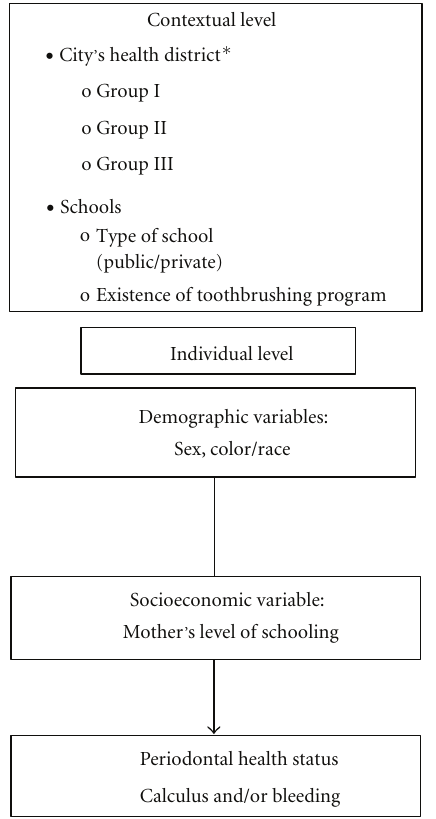
Figure 1: Theoretical hierarchical proposed model of the associa- tion between individual and contextual variables and periodontal health status of 12-year-old schoolchildren. Goiˆania-GO, Brazil,